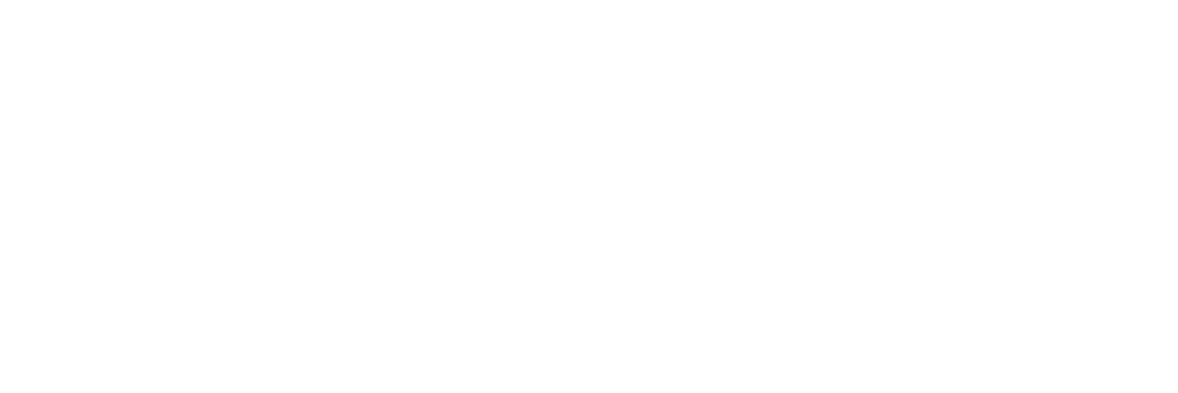
Frontiers in Communication |